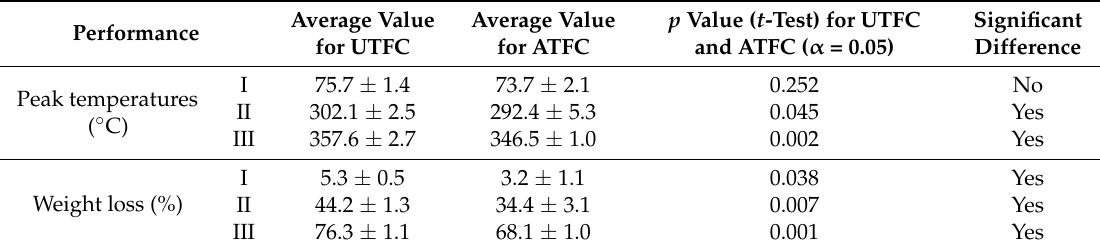
Figure 9. ( a ) TG; and ( b ) DTG curves of PLA, BF, and composites reinforced with untreated and treated BFs. Table 5. Thermal properties of composites obtained from